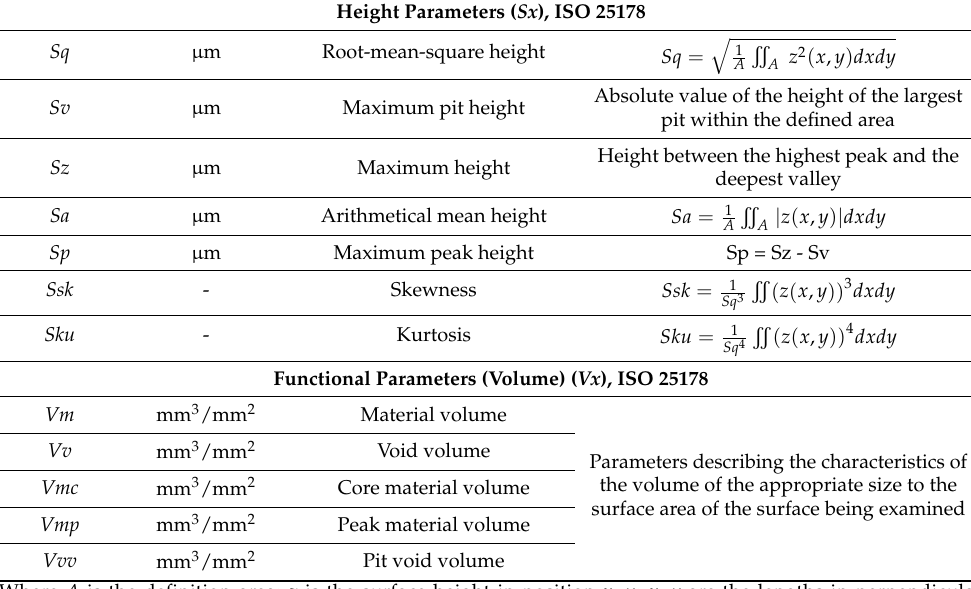
Table 5. Selected parameters for fatigue fracture surface description according to ISO 25178 [47,52].